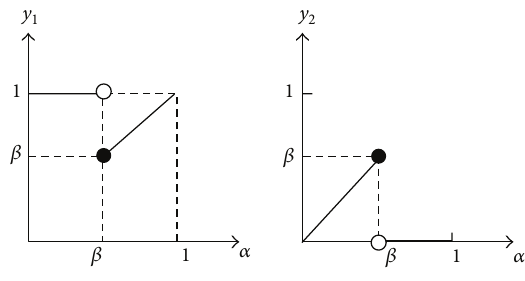
Figure 2: The coordinate frame of functions 𝑦 1 and 𝑦 2